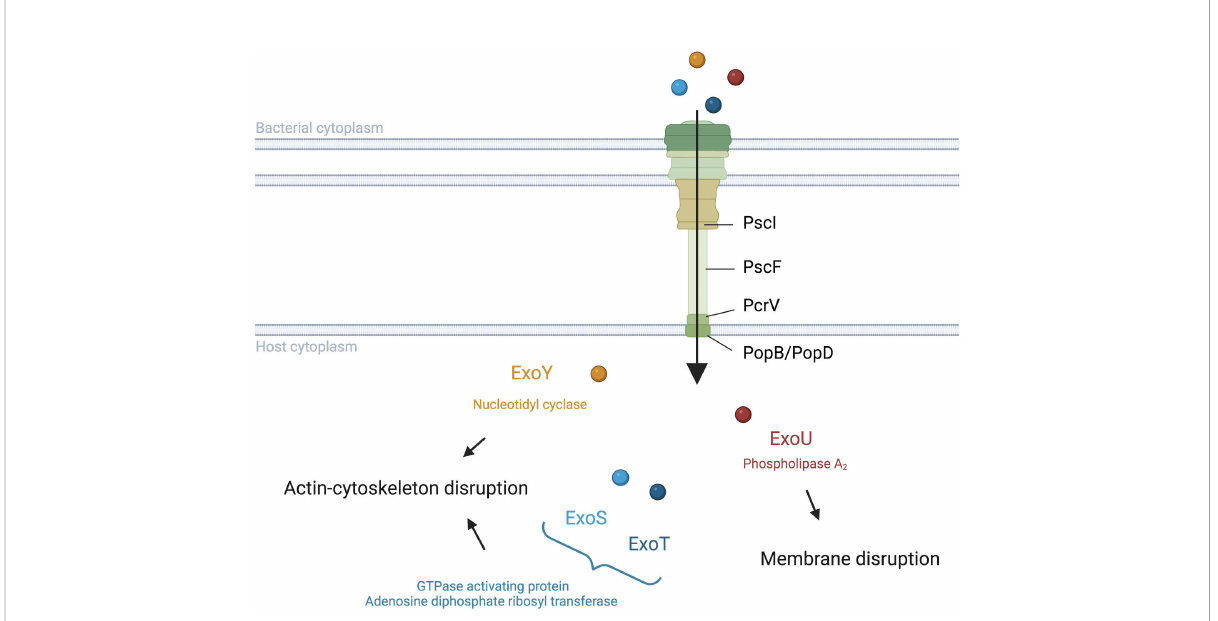
FIGURE 1 Translocation and activities of Pseudomonas aeruginosa T3SS effectors into host cells. P. aeruginosa injects exotoxins though a needle complex after contact with the surface of the targeted eukaryotic cell. ExoS and ExoT modulate the cytoskeleton with their GAP and ADPRT domains (Barbieri and Sun, 2005). ExoY also impacts the actin cytoskeleton but with its Nucleotidyl Cyclase activity (Belyy et al., 2018). ExoU disrupts the integrity of the lipid membrane via its PLA2 activity (Schulert et al., 2003; Sato and Frank,